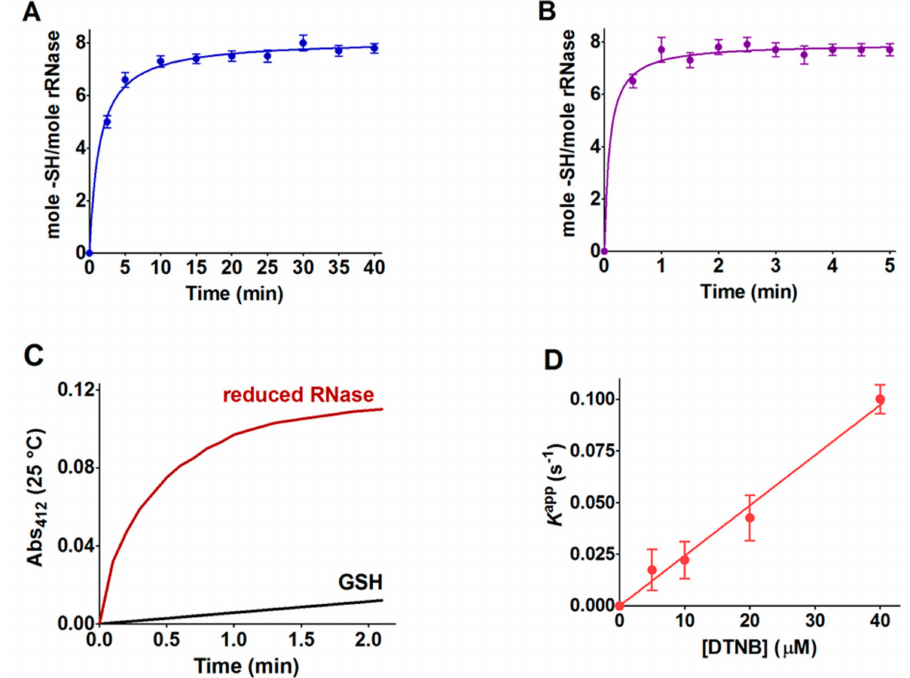
Figure 1. Reduction of the RNase and reaction of the rRNase with DTNB. The reduction of the RNase (0.05 mM) was performed in 10 mM borate bu ff er, pH 8.5, with 0.5 mM DTT and urea 8 M at two di ff erent temperatures 37 ◦ C ( A ) and 60 ◦ C ( B ) (fit obtained using Equation (1)). The reduced cysteines were titrated at di ff erent times as reported under Methods. Average ± SD derived from ten independent experiments. ( C ) 1.25 nmol of the rRNase (about 10 nmol titratable cysteines) was reacted with 20 nmol DTNB in 1 mL of 0.1 M sodium acetate bu ff er, pH 5.0 and 0.2 M urea (red line). For comparison, an identical reaction was performed with 10 nmol of GSH (black line). ( D ) First-order kinetic constants for the reaction of the eight cysteines of the rRNase with di ff erent DTNB concentrations at pH 5.0 and 0.2 M urea. Average ± SD derived from three independent